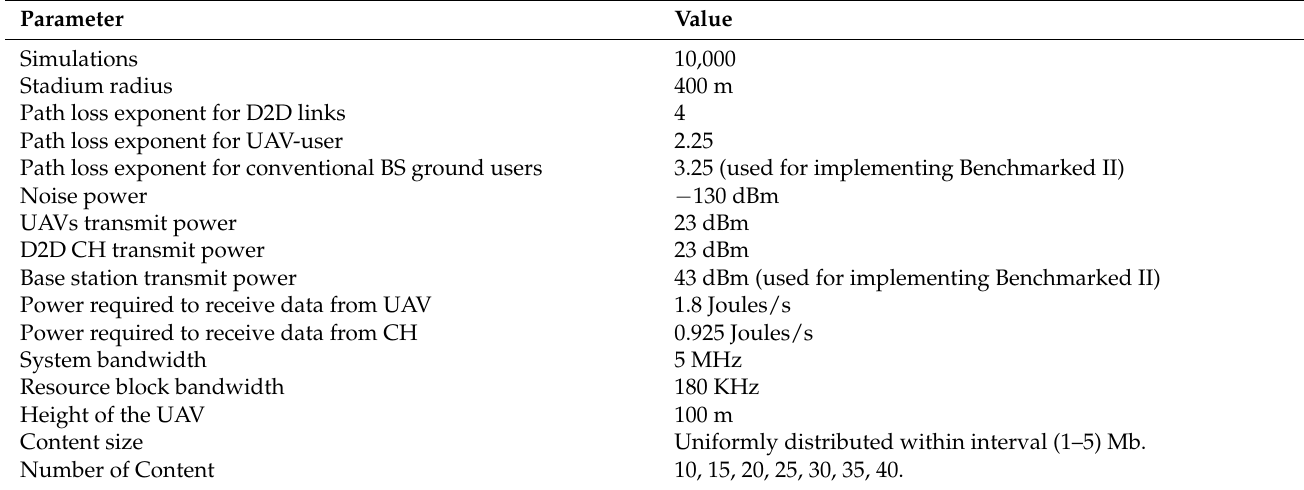
Table 2. Simulation